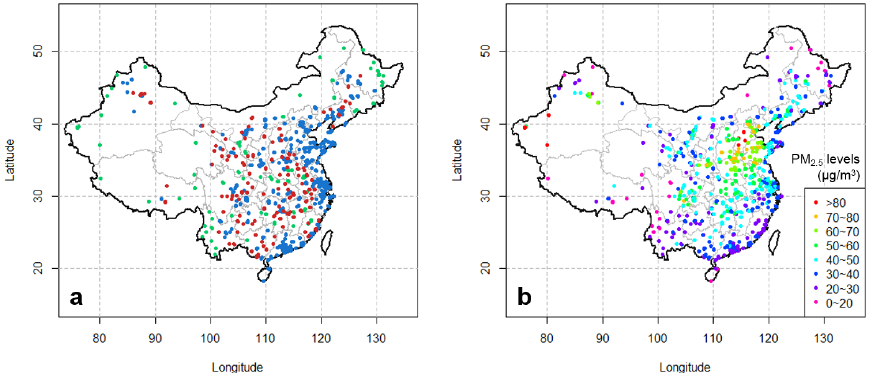
Figure 1. ( a ) Avg-monitors used in this study. The monitors located in the same grid cell have been averaged to derive avg-monitors. The blue dots denote the monitors operational since 2014. The red and green dots both denote monitors operational since 2015, but the red dots represent monitors that are used for evaluating the “final product”. ( b ) Annual mean PM 2.5 concentrations observed at avg-monitors in 2016.